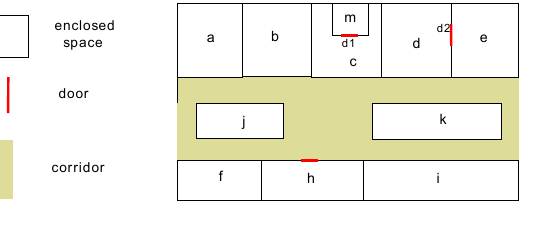
Figure 4. Predicates used in this work.